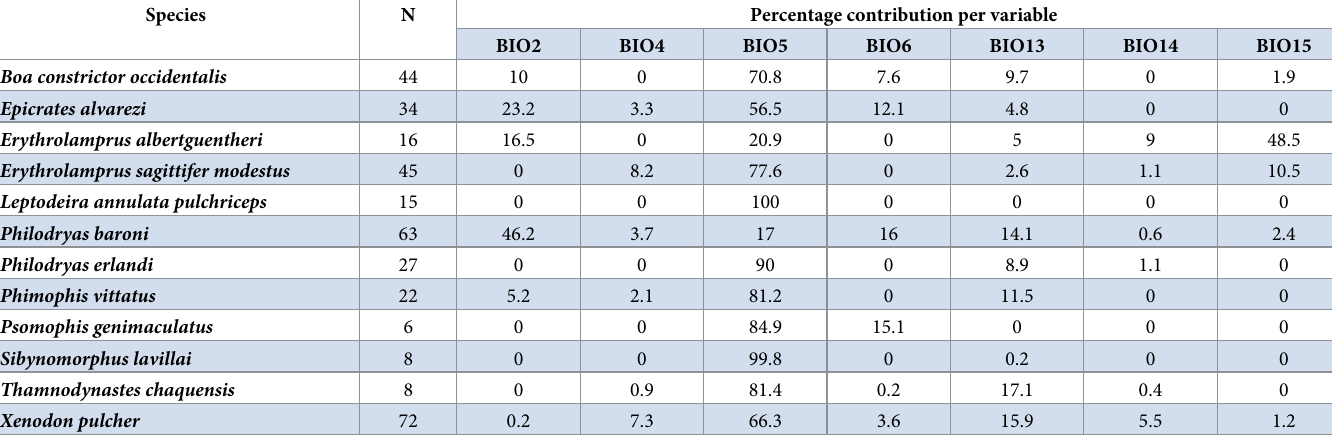
N = number of occurrence records used in models. BIO2 = Mean Diurnal Range (Mean of monthly (max temp—min temp)); BIO4 = Temperature Seasonality (standard deviation � 100); BIO5 = Max Temperature of Warmest Month; BIO6 = Min Temperature of Coldest Month; BIO13 = Precipitation of Wettest Month; BIO14 = Precipitation of Driest Month; BIO15 = Precipitation Seasonality (Coefficient of